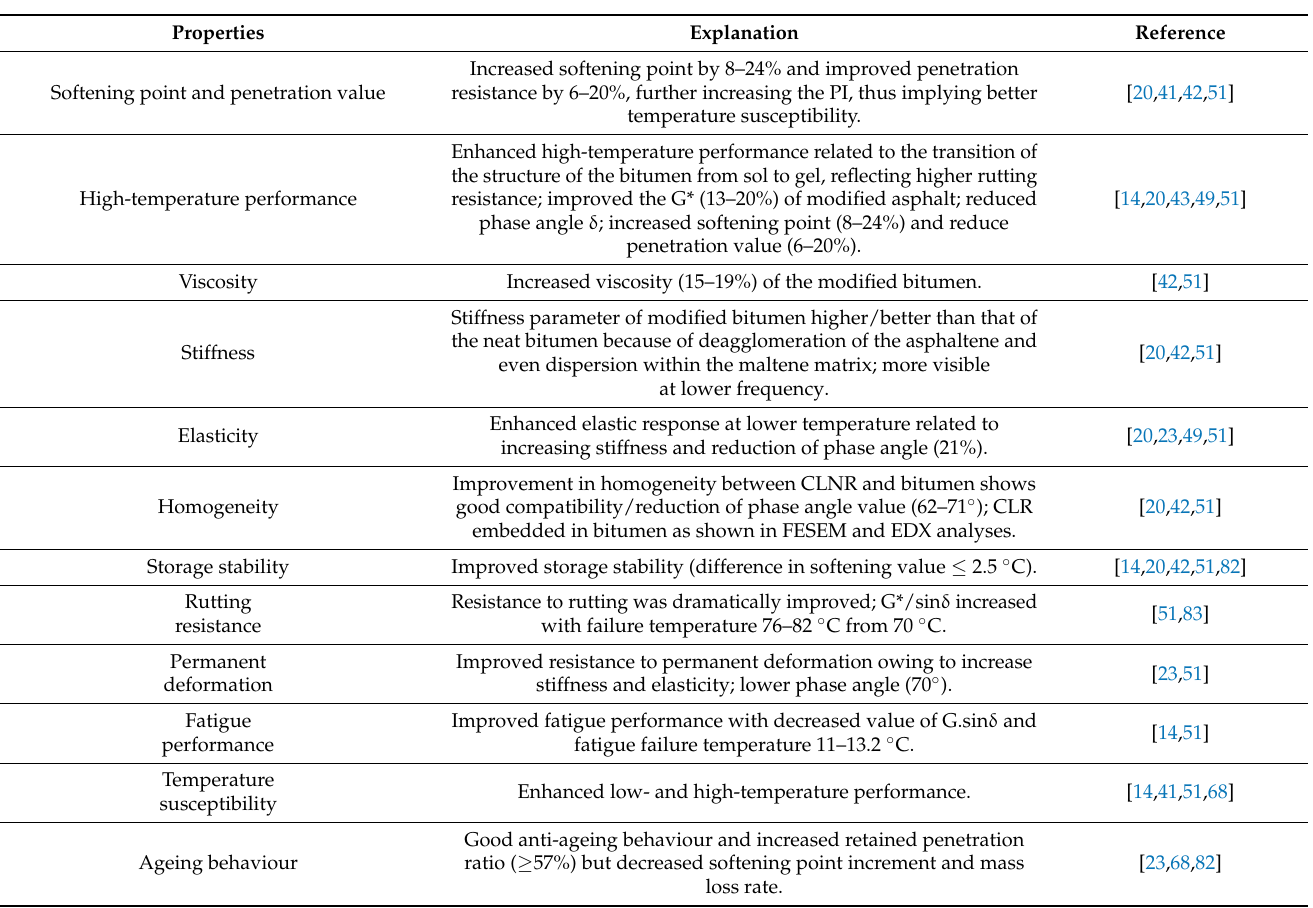
Table 18. Significant properties of PPA